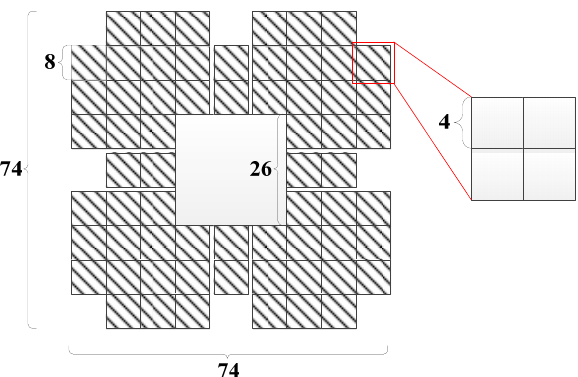
Figure 4. Marker area with embedded watermark. Table 1. Applying the Hamming window to filter out non-overlapping feature